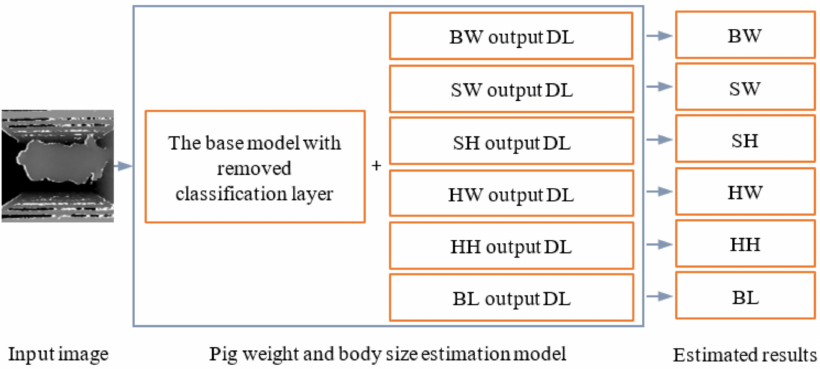
Figure 6. Pig weight and body size estimation model and estimate process. DL: dense layer; BW: body weight; SW: shoulder width; SH: shoulder height; HW: hip width; HH: hip height; BL: body